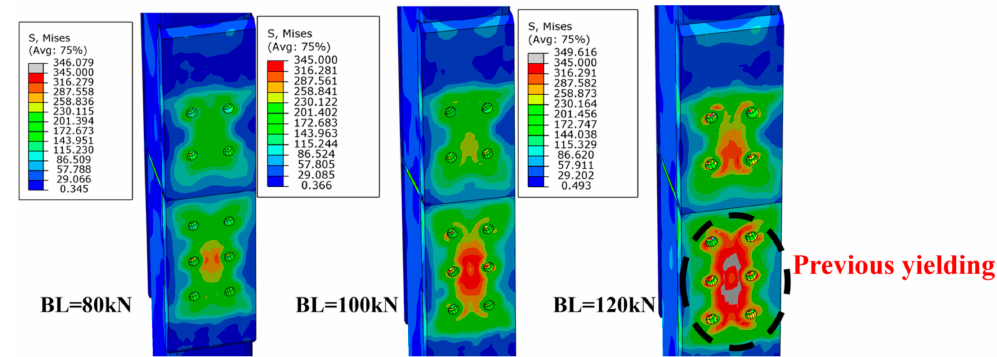
Figure 12. Stress distribution of columns with different bolt